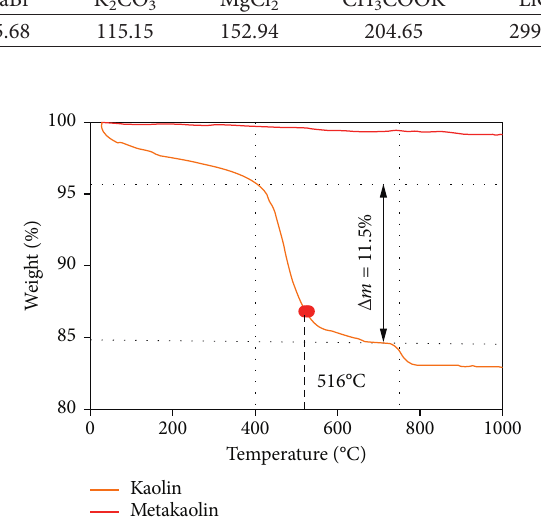
Figure 5: Thermogravimetric analysis curves of kaolin and